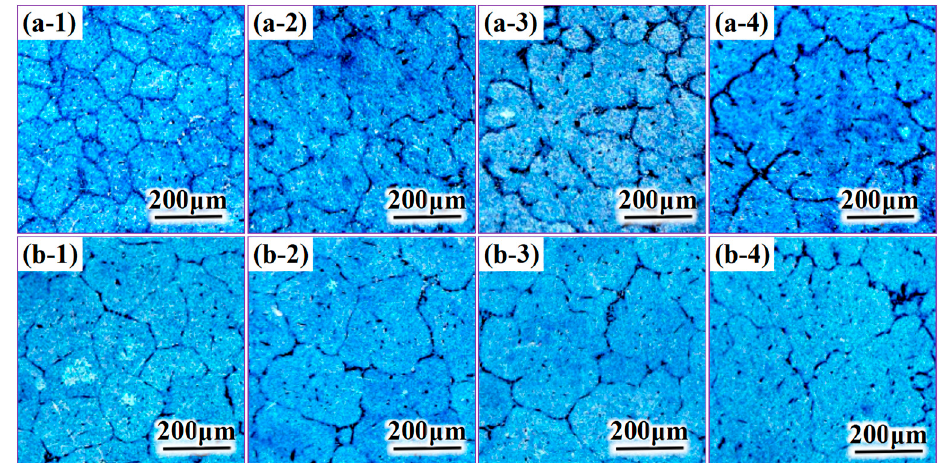
Figure 5. Comparison of microstructure at the same position on the cross-sections of the two ingot